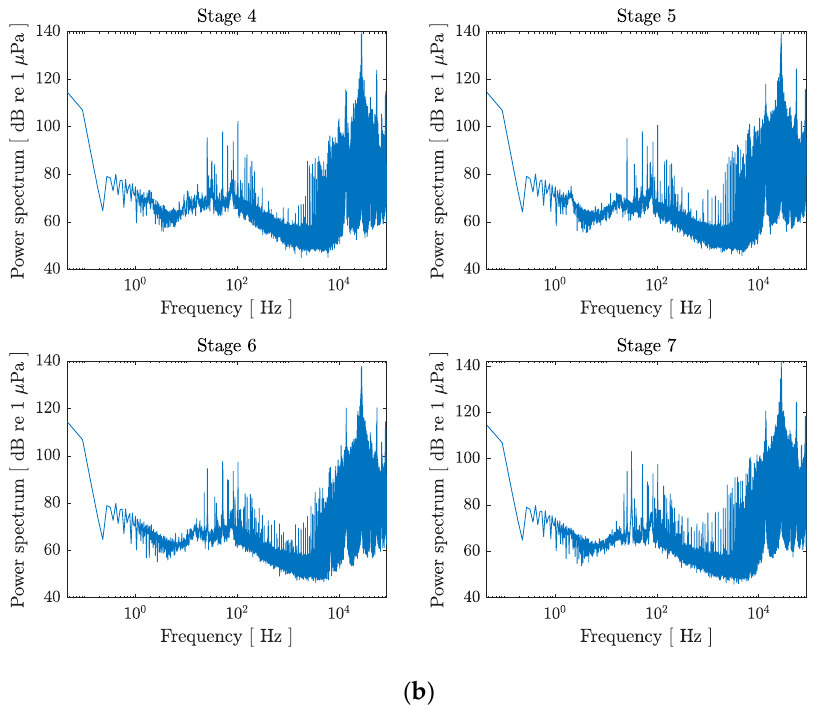
Figure 15. Power spectral density values for ( a ) stages 0 to 3 and ( b ) stages 4 to 7 at grid point 1a.